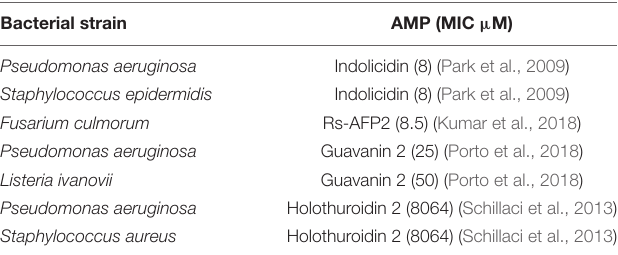
TABLE 4 | Minimum inhibitory concentration (MIC) values of several natural antibacterial peptides. Bacterial